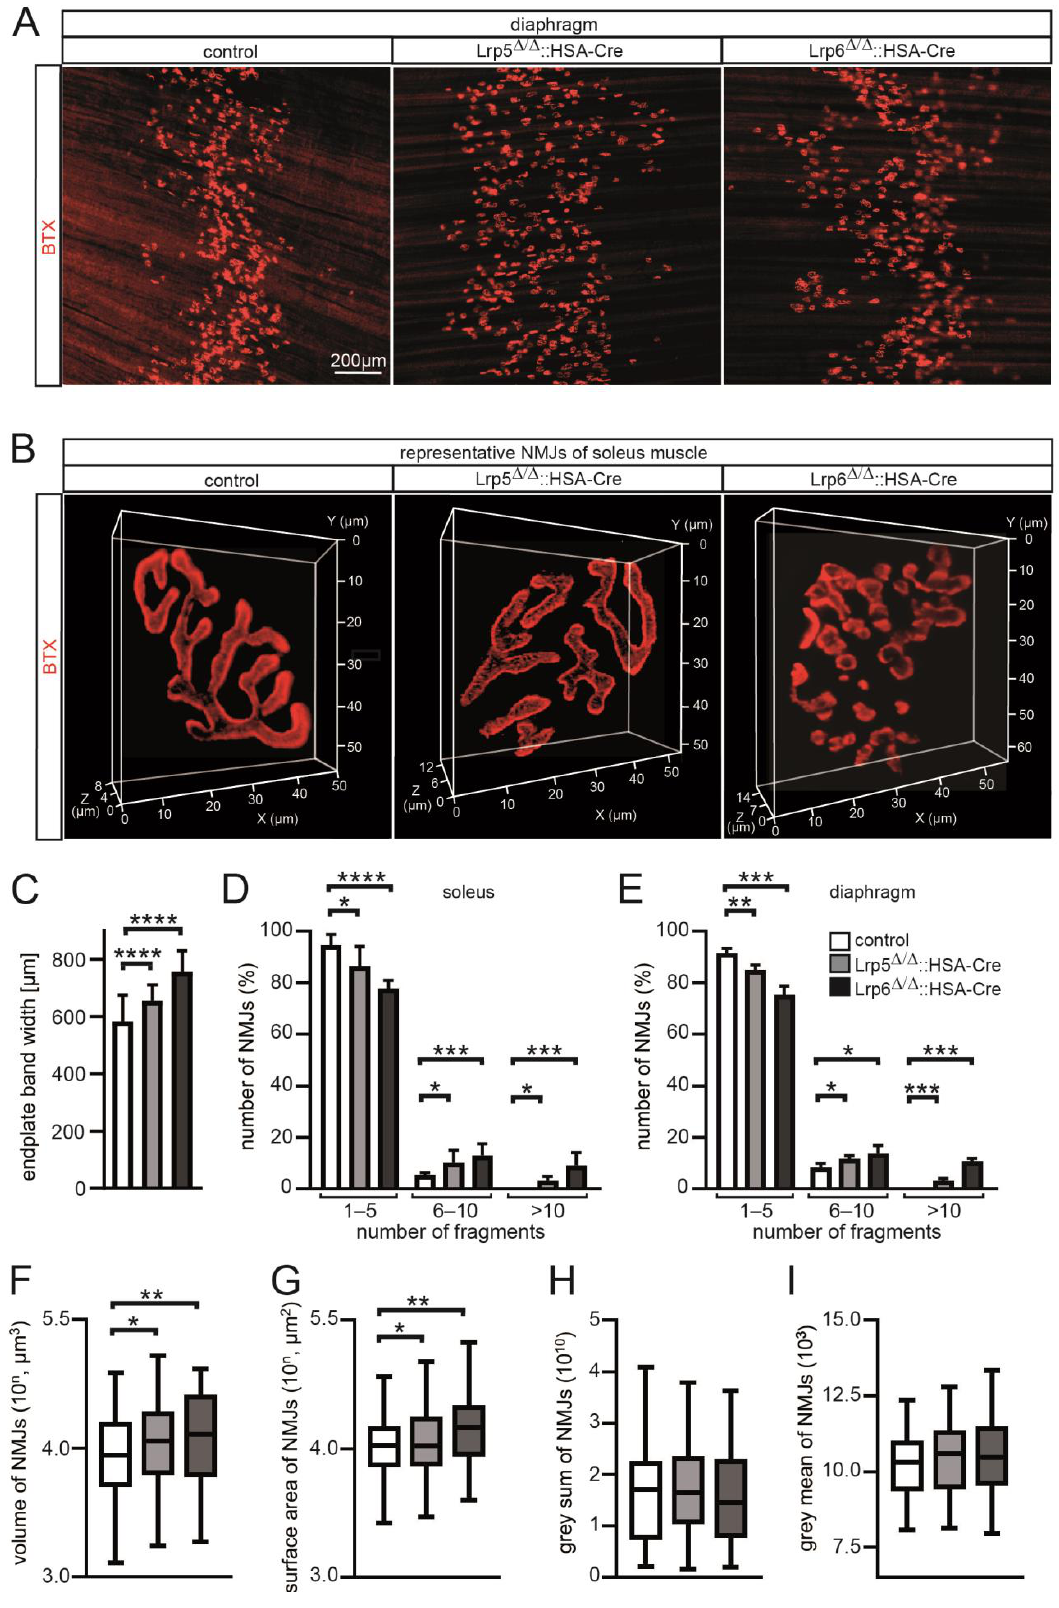
Figure 5. Endplate band width is gradually increased and NMJs are fragmented in conditional Lrp5 and Lrp6 knockout mice. ( A ) Representative images of BTX-stained diaphragms from control and mutant adult mice are shown. ( B ) Typical 3D images from individual NMJs of control and mutant soleus